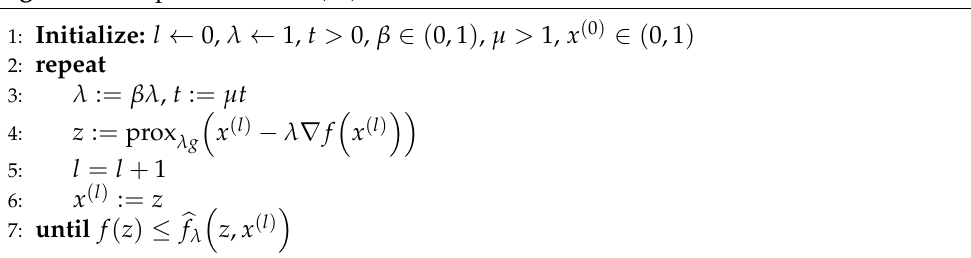
Algorithm 1 Optimization of (22) with Proximal Gradient